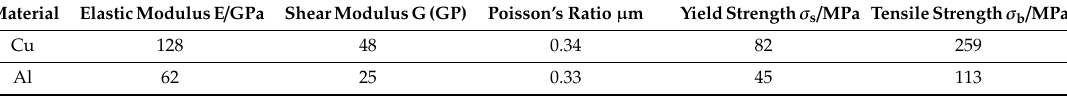
Table 3. Mechanical properties of Al and Cu